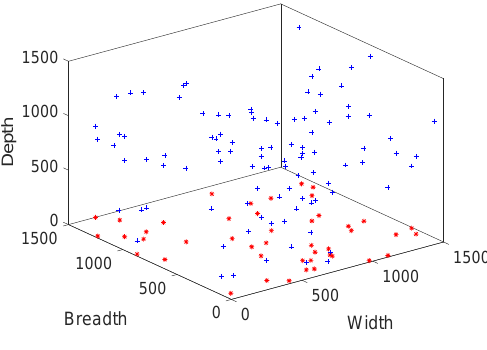
Figure 8. Initial deployment.